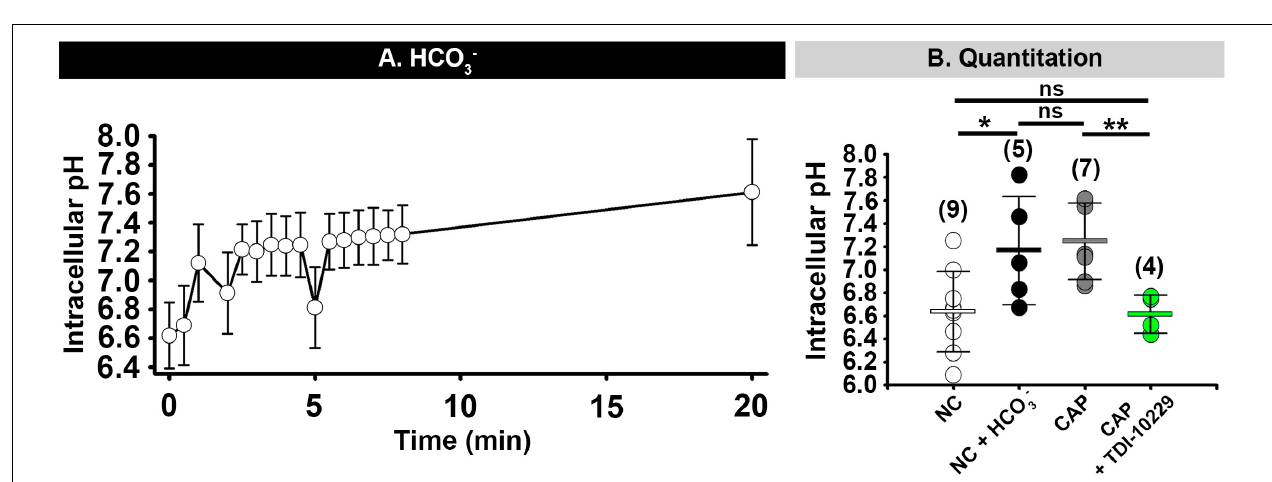
FIGURE 8 | The sACspecific inhibitor TDI-10229 impairs [Ca 2 + ]i responses to KCl in ejaculated human sperm. (A–D) Representative traces of [Ca 2 + ] i responses to 50 mM KCl at (A,B) pH 6.8 and (C,D) pH 8.0 in ejaculated human sperm in non-capacitating conditions in (A,C) control and (B,D) after pre-incubation with TDI-10229. (E) Linear fit of the averaged normalized fluorescence in the first 20 s after KCl addition at pH 6.8 and pH 8.0. (F) Graph of slope values of the best-fit regression line for each condition. Mean values at pH 6.8 were as follows: control, 1.80 ± 0.82 amplitude units * s − 1 (26 samples, 1836 sperm); and TDI-10229 incubation, 0.426 ± 0.276 amplitude units *s − 1 (5 samples, 2279 sperm). Mean values at pH 8.0 were as follows: control, 1.73 ± 0.594 amplitude units * s − 1 (26 samples, 3036 sperm); and TDI-10229 incubation, 0.491 ± 0.305 amplitude units *s − 1 (5 samples, 2279 sperm). (G) Graph of the percentage of responsive sperm. Mean values at pH 6.8 were as follows: control, 66.94% ± 24.30 (26 samples, 1836 sperm); and TDI-10229 pre-incubation, 16.18% ± 10.10 (5 samples, 2279 sperm). Mean values at pH 8.0 were as follows: control, 77.04% ± 18.67 (26 samples, 3036 sperm); and TDI-10229 pre-incubation, 35.43% ± 15.77 (5 samples, 2279 sperm). * P < 0.050, ** P < 0.010, and *** P < 0.001 by independent t -test. Error bars indicate standard deviation. Iono = 5 µ M Ionomycin + 2 mM Ca 2 + .